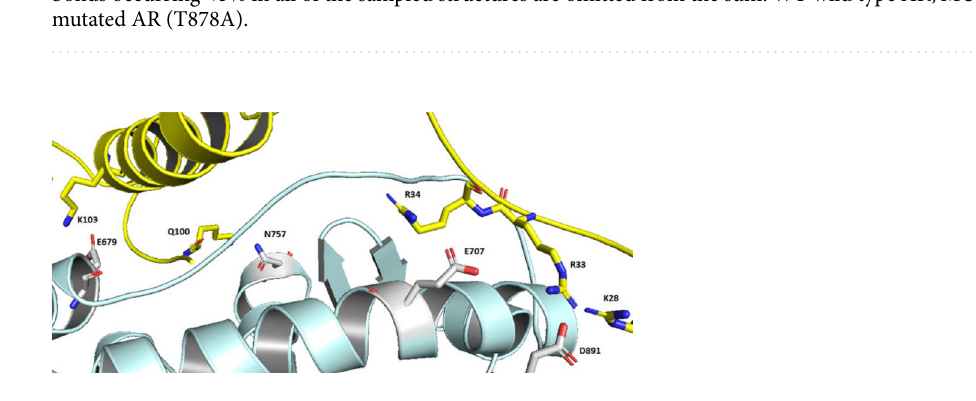
Figure 5. Amino acid residues that form the strongest intermolecular AR (pale blue)—SHH-N (yellow) interactions during MD